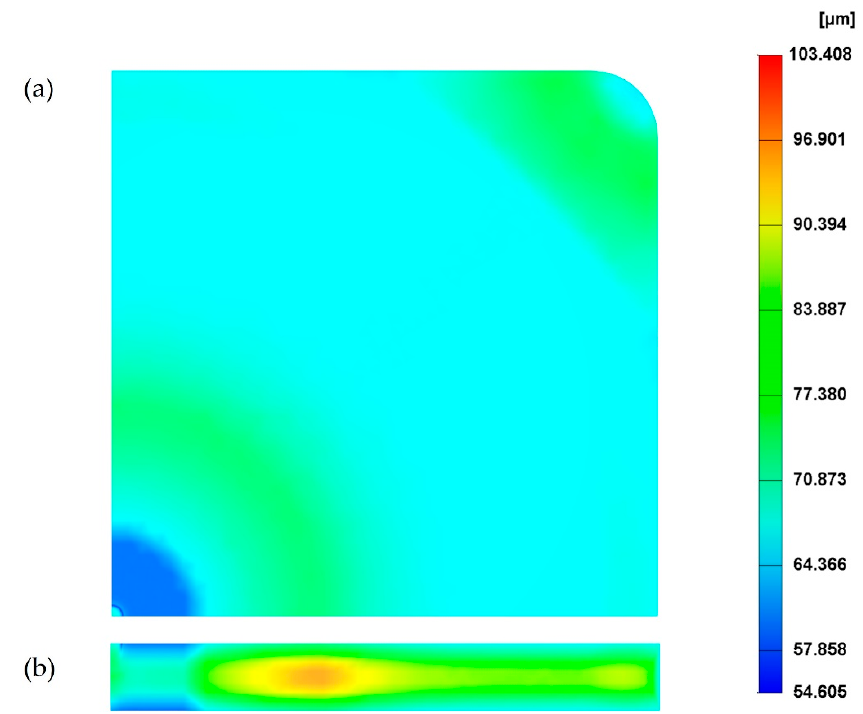
Figure 9. Cell size distribution on the surface ( a ) and cross-section ( b ) of the MuCell ® part considering a gas dosage amount is 0.5%.